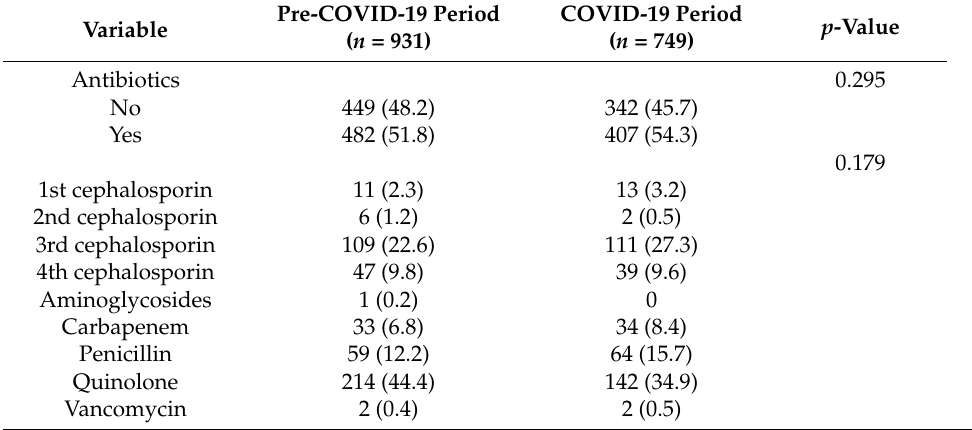
Table 4. The distribution of antibiotics administered to patients by the Pre- and COVID